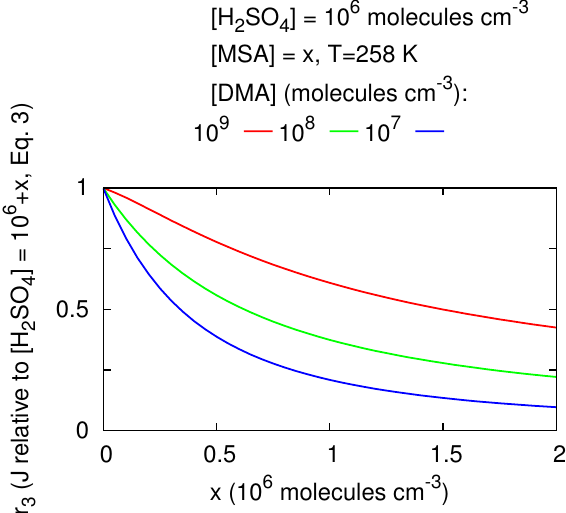
Figure 3. Cluster formation rate of added MSA relative to the same amount of added H 2 SO 4 as defined in Eq.